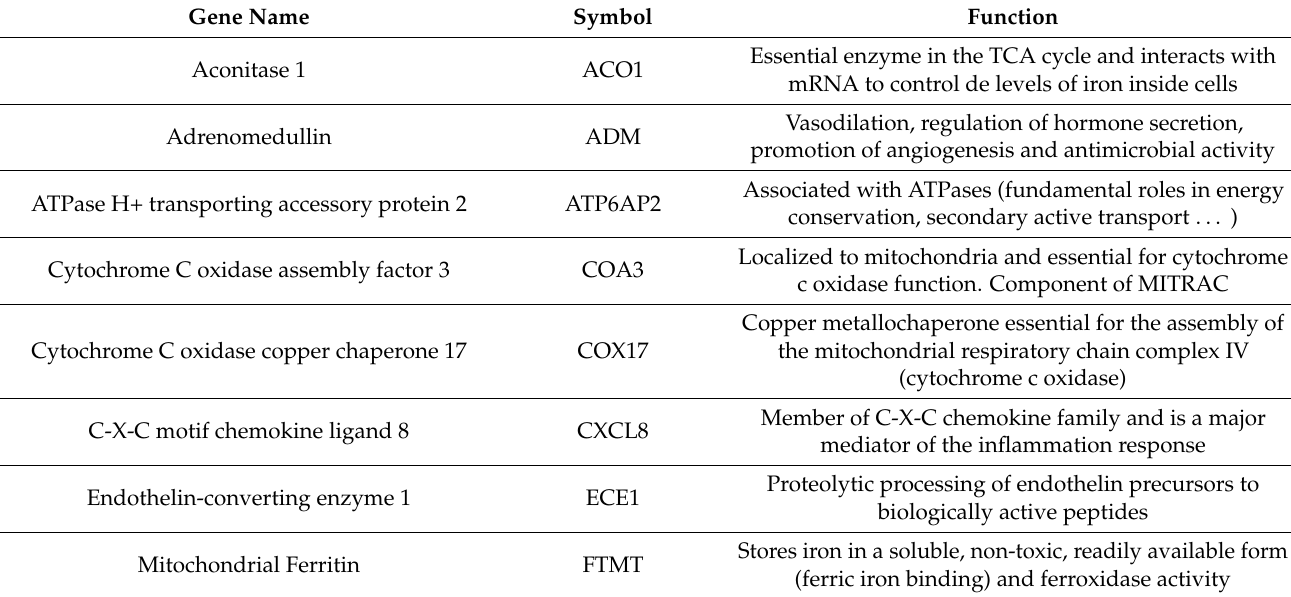
Table 2. General function of the 22 candidate genes analyzed by TLDA (TaqMan ® Low Density Array) in cohort